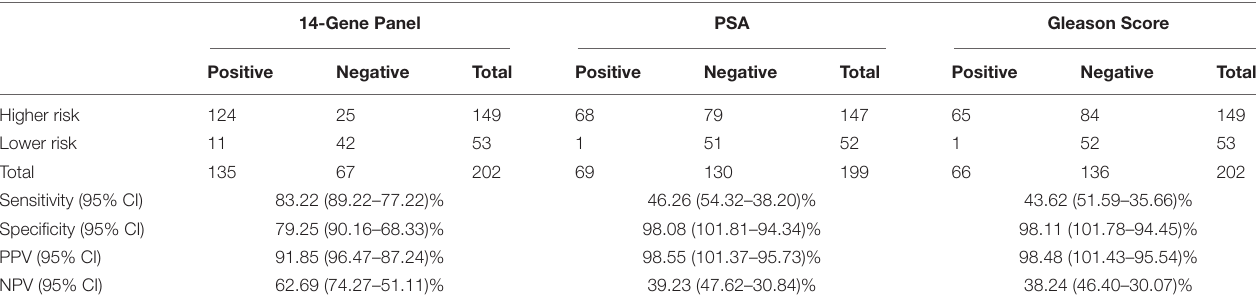
TABLE 3 | Sensitivity, specificity, PPV, and NPV of 14-Gene-Panel, prostate-specific antigen (PSA) and Gleason score for diagnosis of higher-risk and lower-risk prostate cancer (PCa) in a prospective PCa urine cohort. 14-Gene Panel